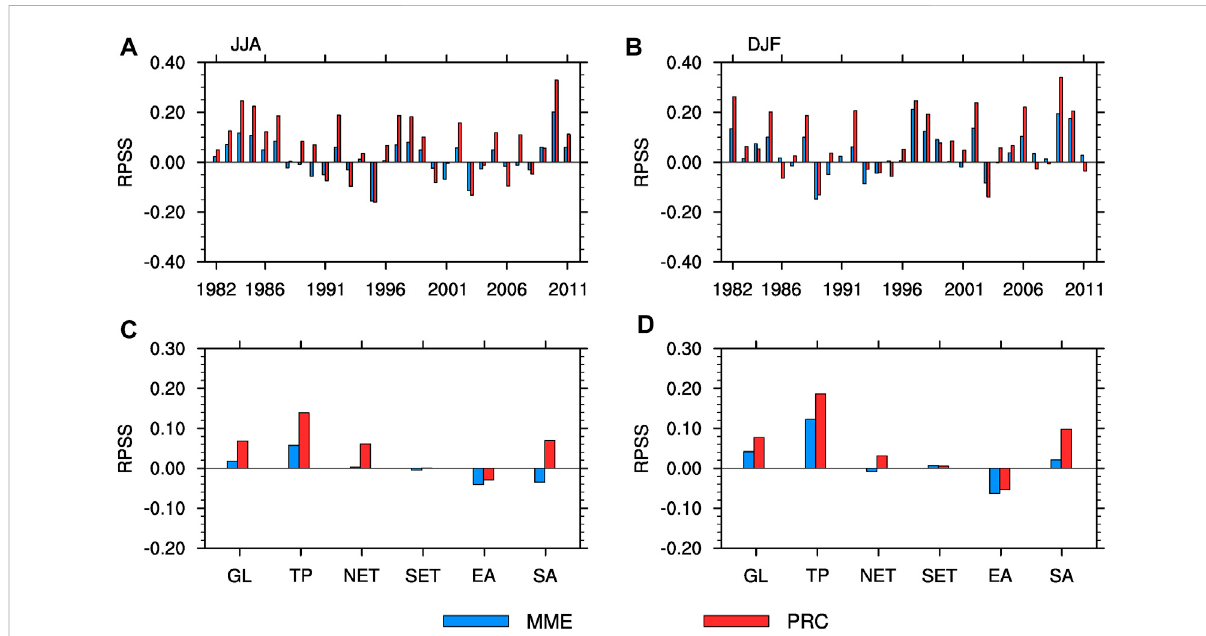
FIGURE 9 Timeseriesoftheglobal-averagedRPSS (A,B) andthearea-averagedRPSSindifferentregions (C,D) forsimpleaveragedmulti-modelensemble (MME) and the ensemble with partial regression (PRC) of temperature in JJA (left panel) and DJF (right panel) season for the period 1982 –